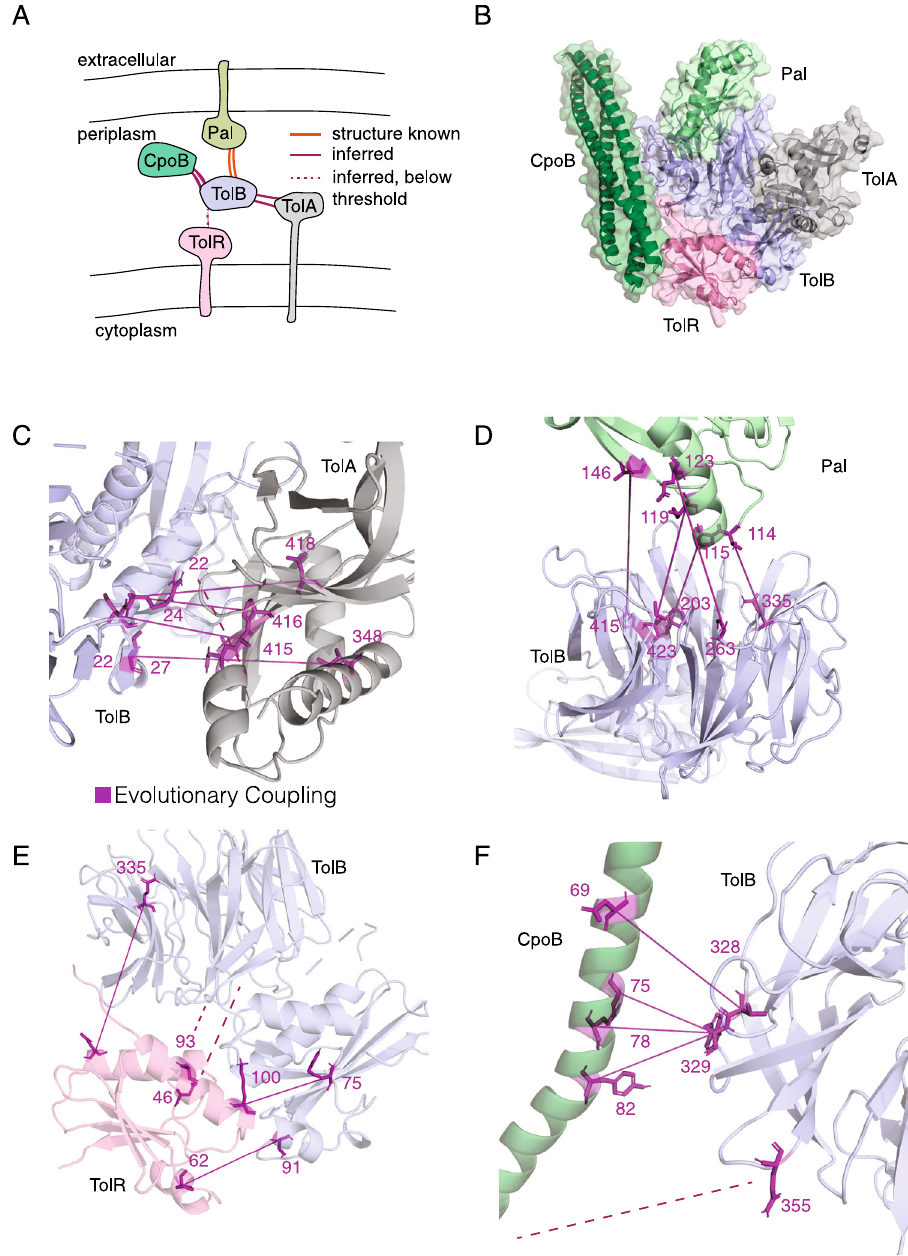
Fig. 5 Atomic resolution model of the Tol-Pal complex. A Schematic of the proteins involved in the Tol-Pal complex 2 (TolABR, CpoB, and Pal). Interactions with previously solved interfaces are shown in orange and interactions inferred by our method are shown in purple. B Complete model of the Tol-Pal complex inferred by aligning results of docked pairwise models. Note that CpoB is inferred to be a trimer in vivo but was docked as a monomer for modeling purposes C – F Residue resolution of TolB-Pal, TolB-TolA, TolR-TolB, and CpoB-TolB interfaces. The top 5 inferred interface contacts are shown in purple. Dashed lines indicate inferred contacts where one or more residues are missing from the solved structure. Structures used are 1TOL_A